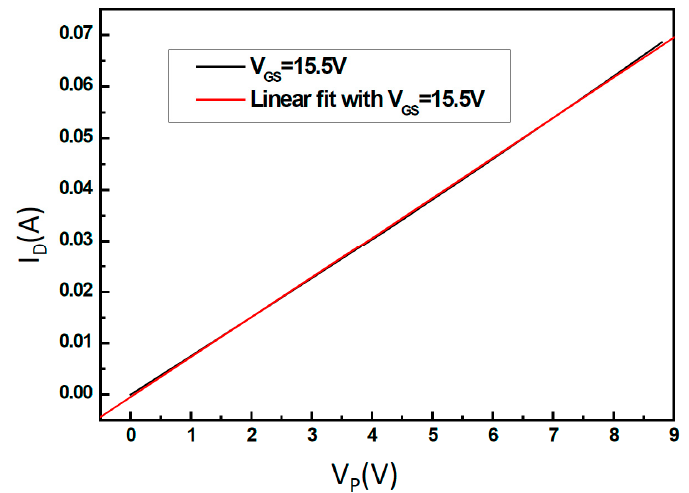
Figure 14. The I D -V P linear curve of the inkjet chip (driver with heater).